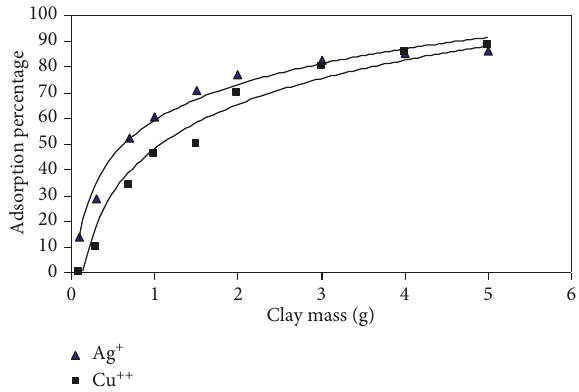
Figure 4: Effect of clay mass on the adsorption percentage.